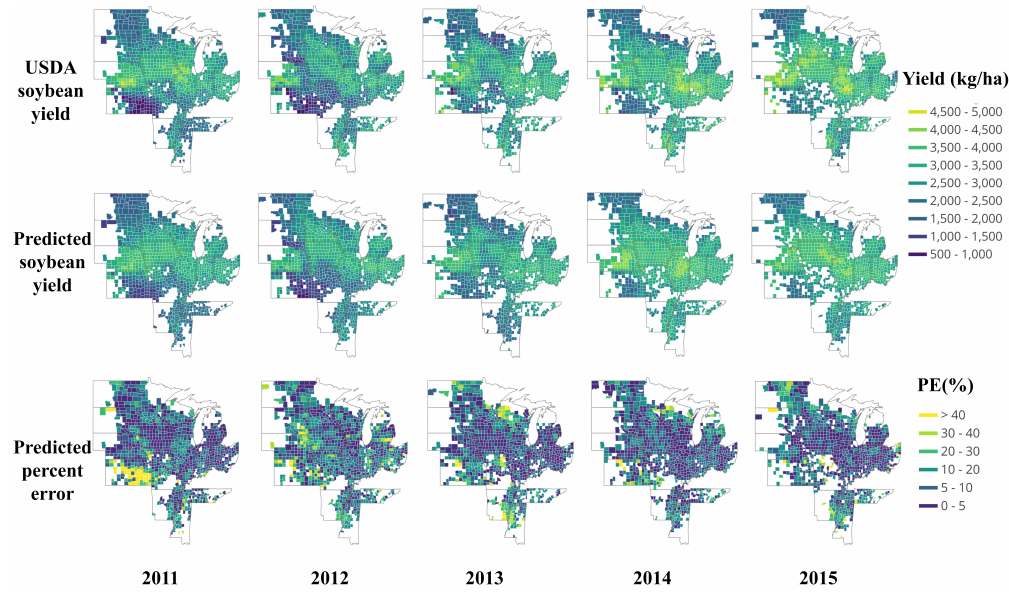
Figure 4. Map of USDA soybean yield, predicted soybean yield, and percent error (PE) from 2011 to